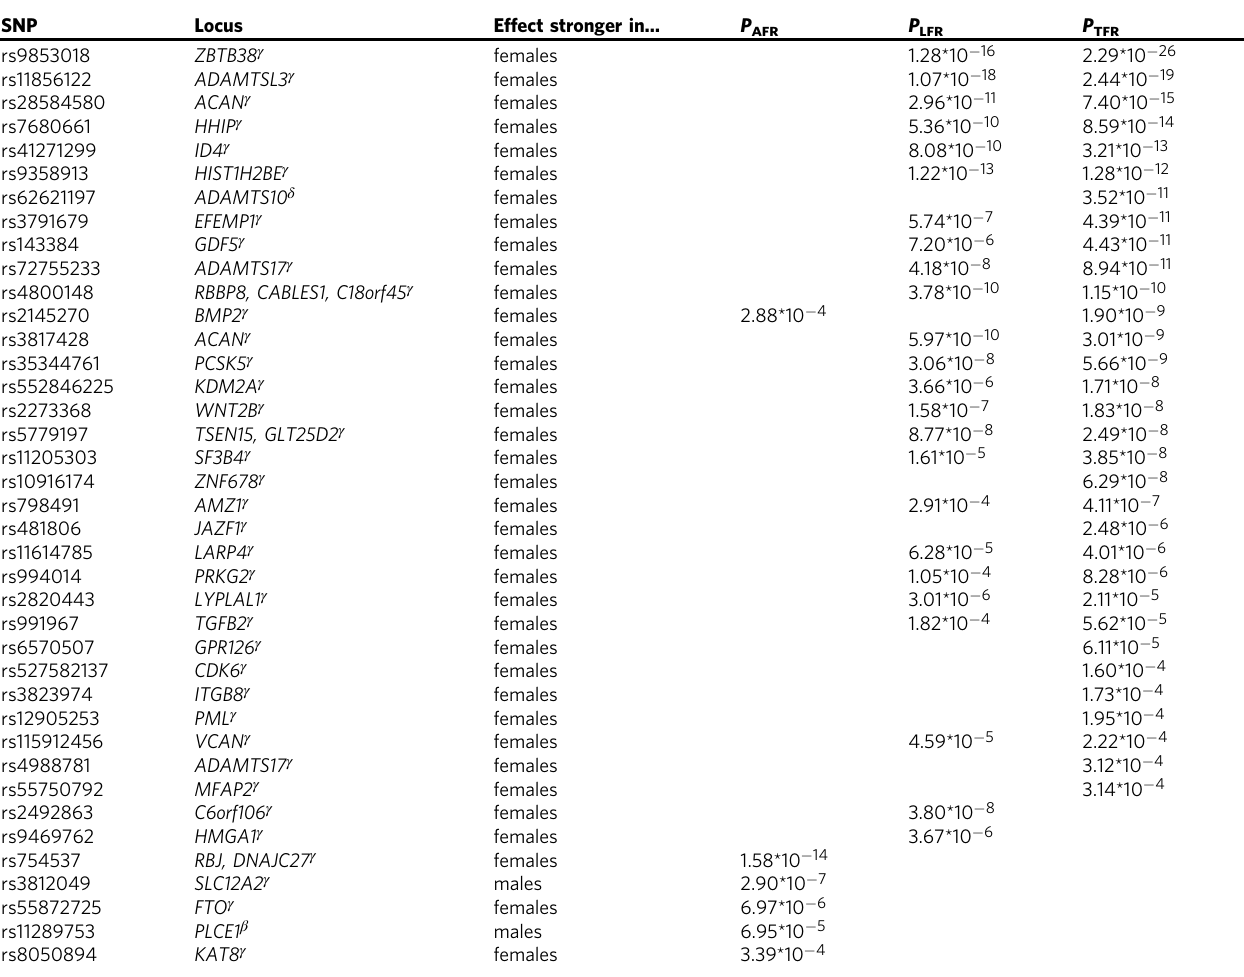
Table 2 Sex heterogeneous effects of body fat ratio-associated SNPs was assessed with GWAMA 56 for all replicated trait- associated